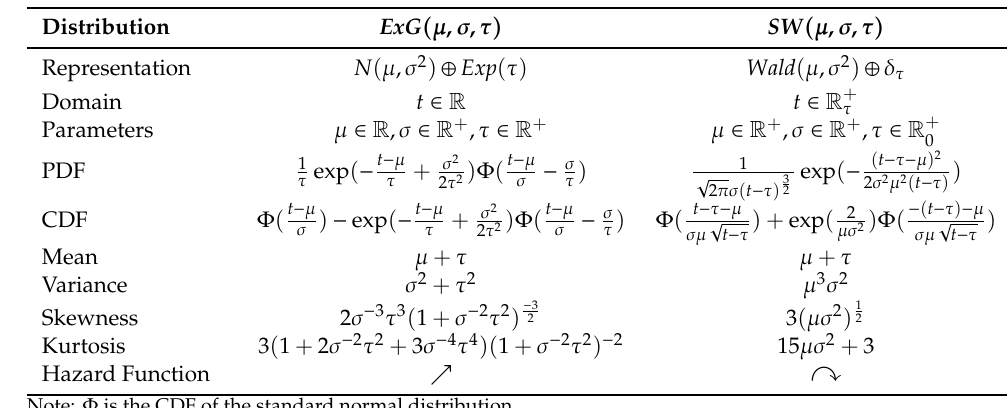
Table 1. A summary of Exponentially modified Gaussian (ExG) and Shifted Wald (SW) distributions’ key